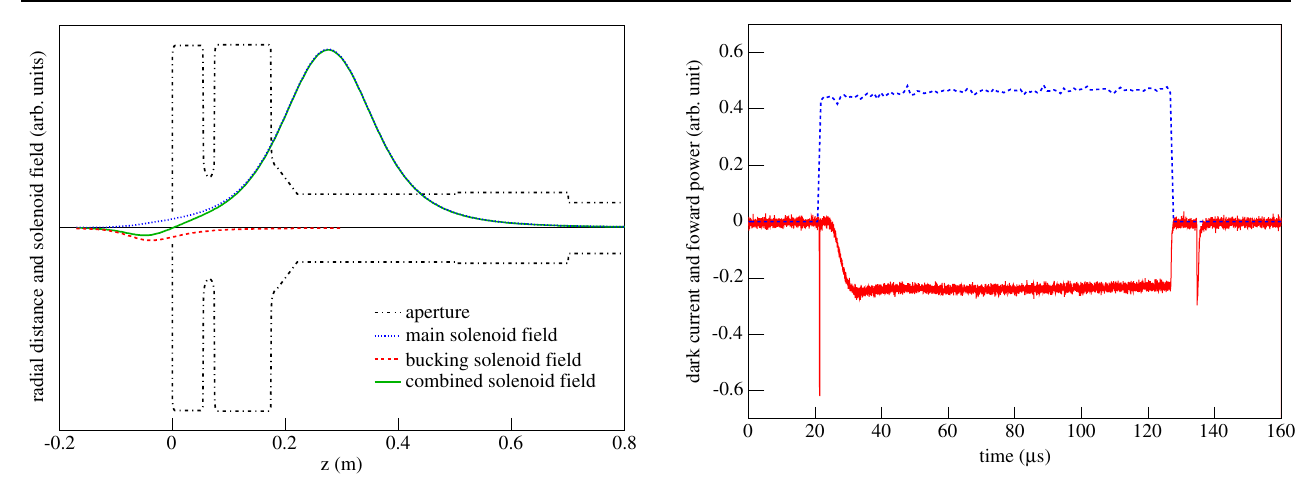
FIG. 5. (Color) On-axis magnetic field distribution for the PITZ solenoids [26] and simplified gun aperture. As an example, solenoid currents are set as 30.5 A and 400 A for the bucking and main solenoids, respectively.